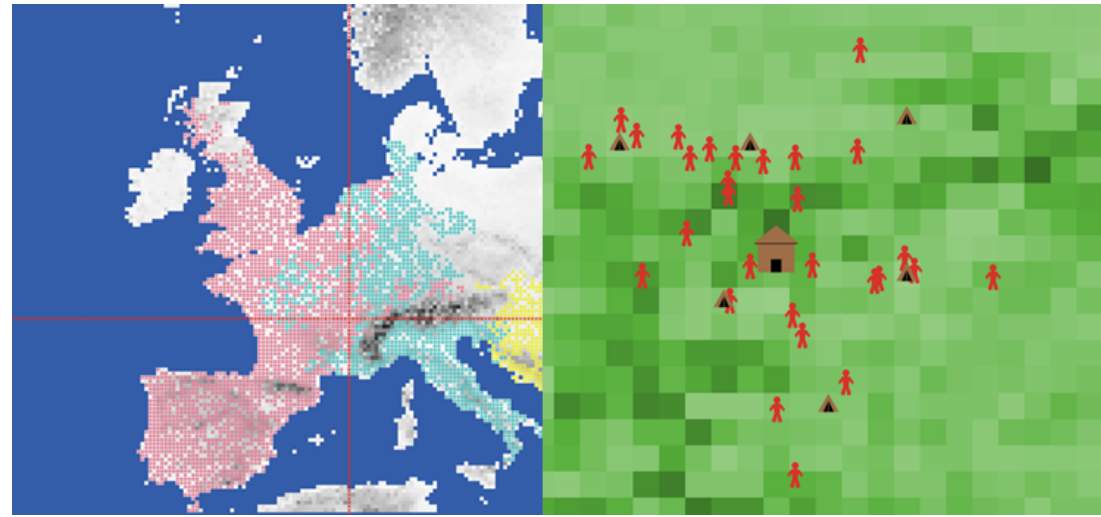
Figure 12. Agent-based models (ABMs) that integrate GIS maps as agent-based modeling environment with which the agents interact. Shown are example visualizations of a continental-scale model ( left ) and a regional scale model ( right